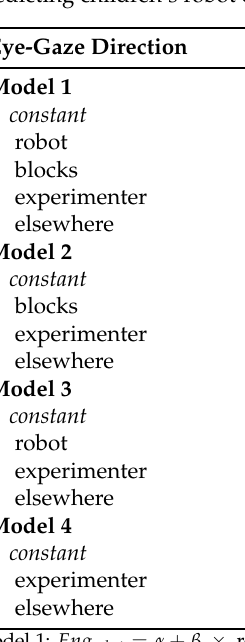
Table 4. Regression analyses summary for the duration (s) that children looked in different directions predicting children’s robot engagement.